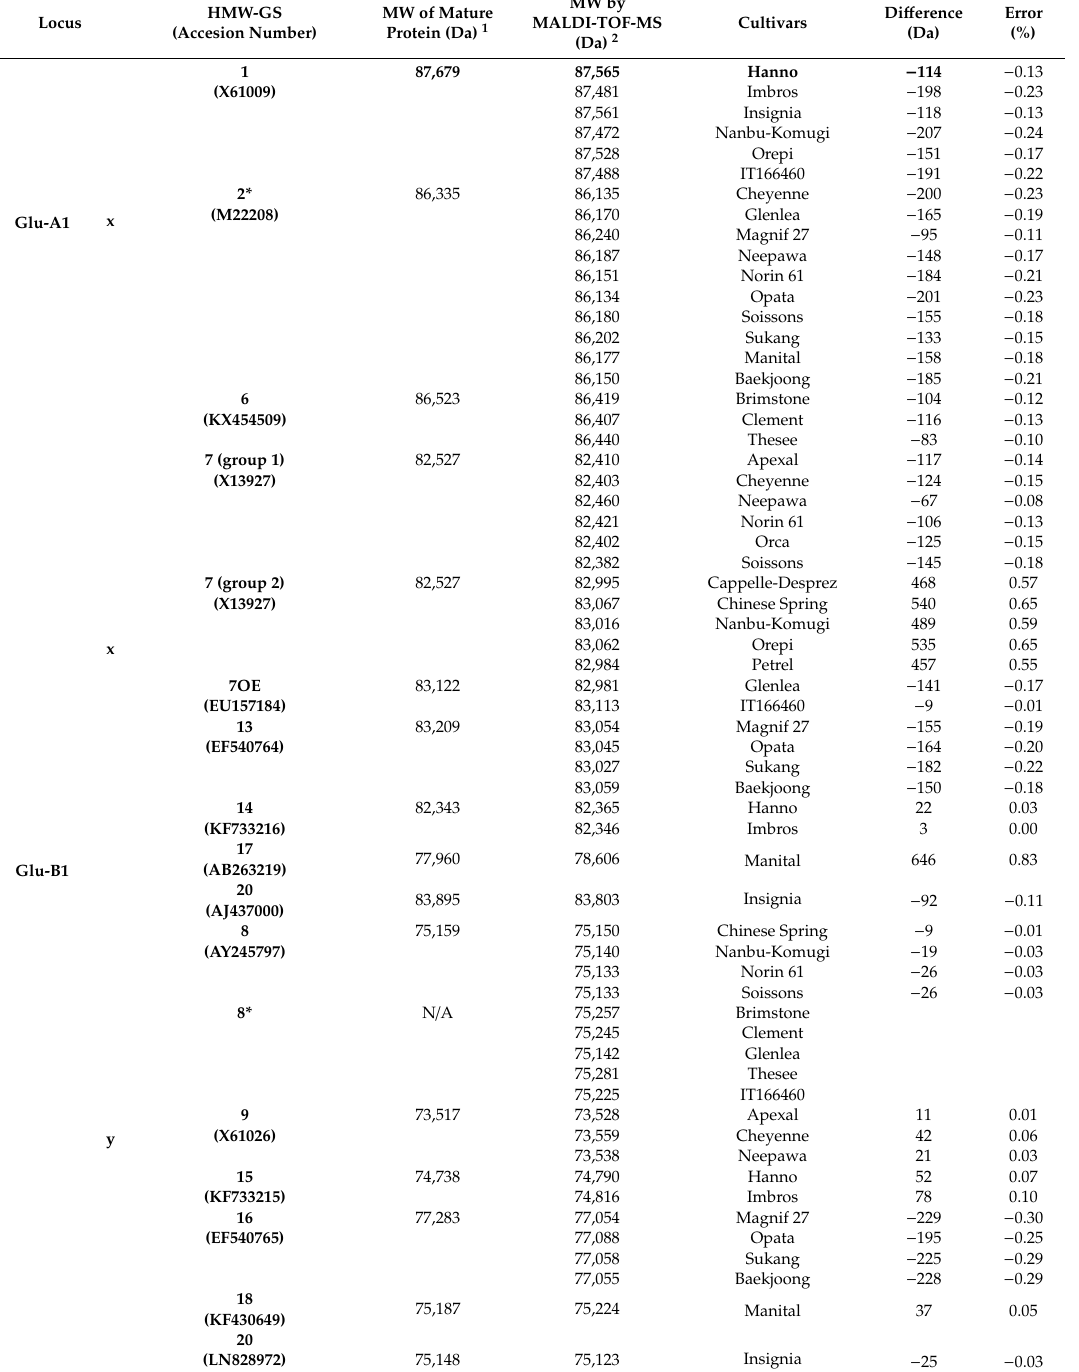
Table 3. Comparison of molecular weights of HMW-GS predicted from mature proteins deduced from gene sequences with actual molecular weights determined by MALDI-TOF-MS in standard cultivars.